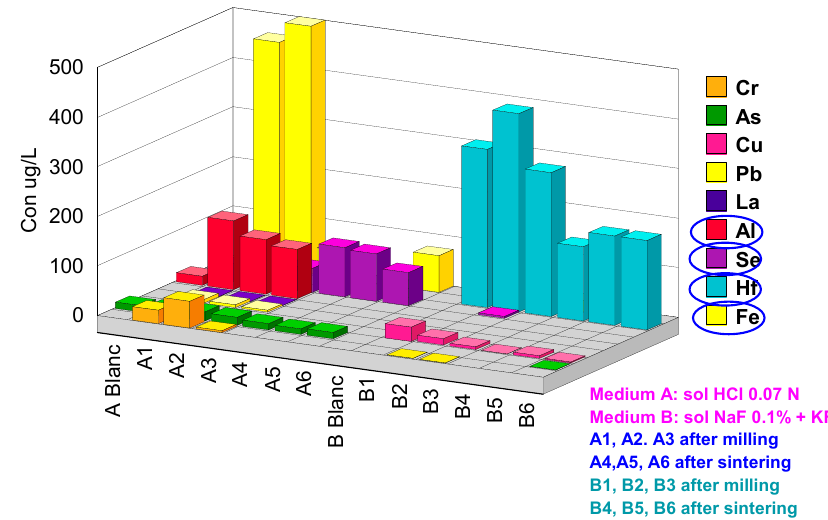
Figure 7. Cations released in the hundredth μ g/L scale.